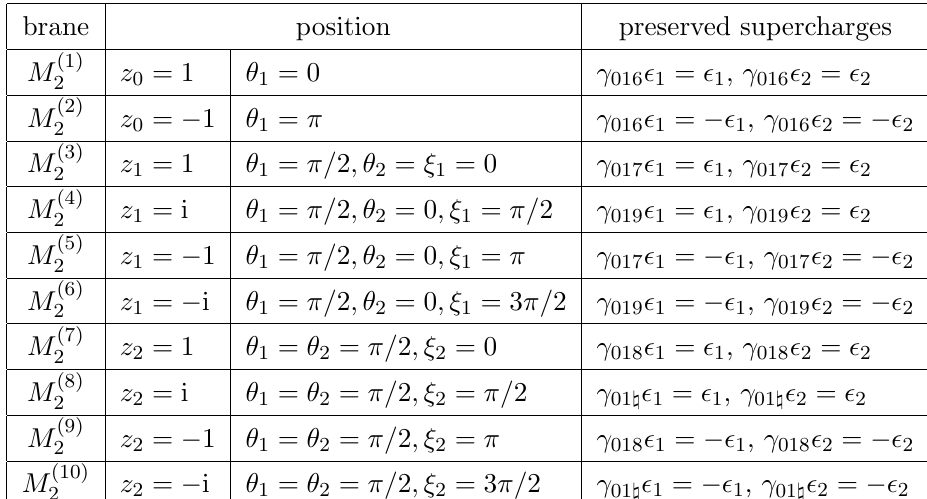
Table 6. Ten di(cid:11)erent M2-branes placed at di(cid:11)erent positions, and their preserved supercharges.